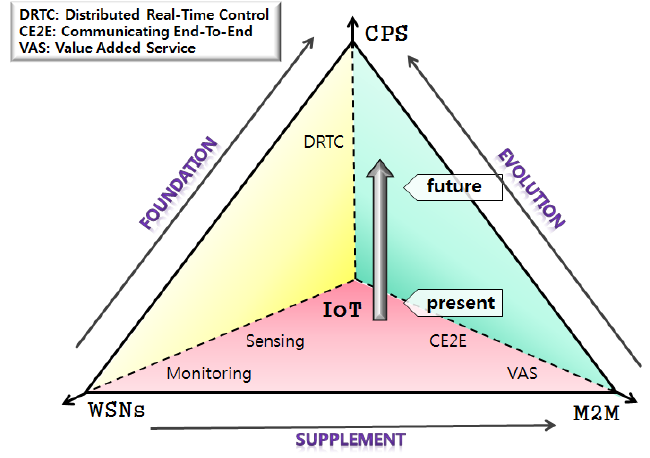
Figure 1. Application range of the CPS.